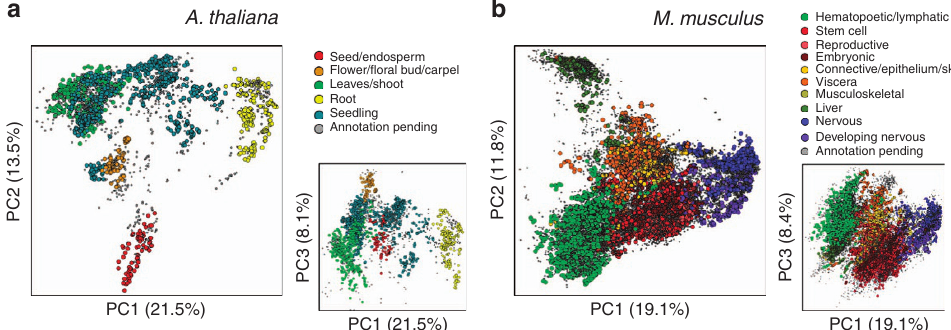
Figure 1 | The primary drivers of transcriptomic variation are developmental stage and tissue. ( a ) A. thaliana , ( b ) M. musculus . Also shown are plots of PC3 versus PC1 to provide additional